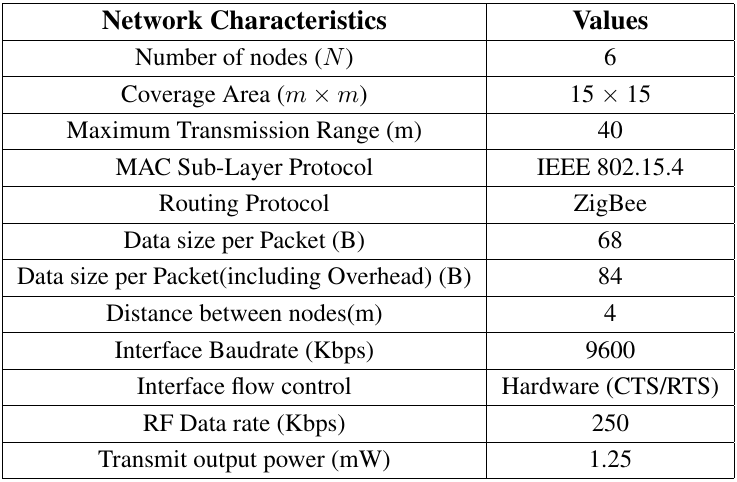
Table 2 . Experimental configuration of the utilized WN